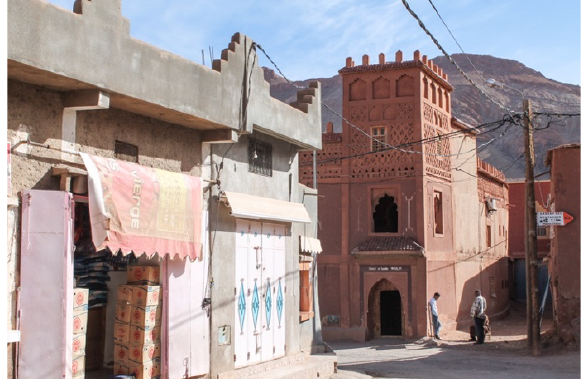
Figure 19. “Riad Bérbere Boutaghrar”, Bou Taghrar.